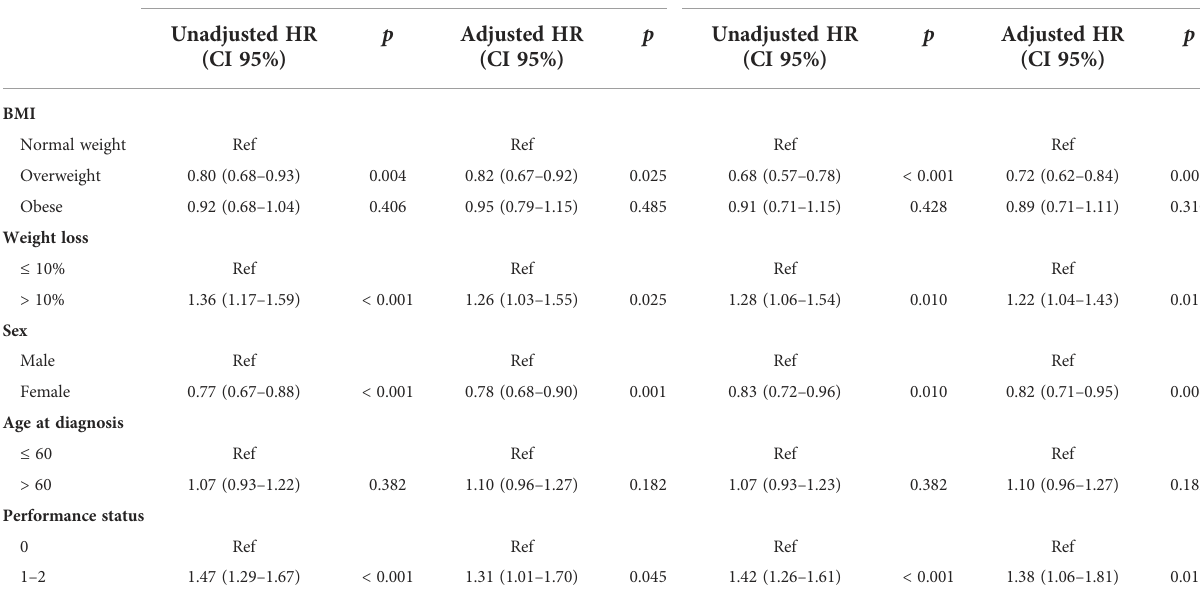
TABLE 3 Associations between BMI and clinical factors with outcome in right-sided tumors. Overall